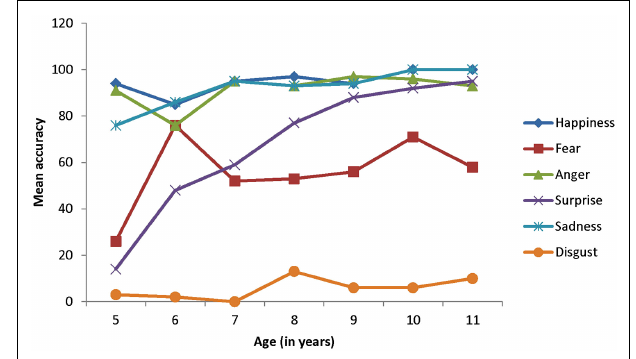
FIGURE 1 | Mean accuracy (expressed in percentage) in labeling facial expressions as a function of age and type of expression.